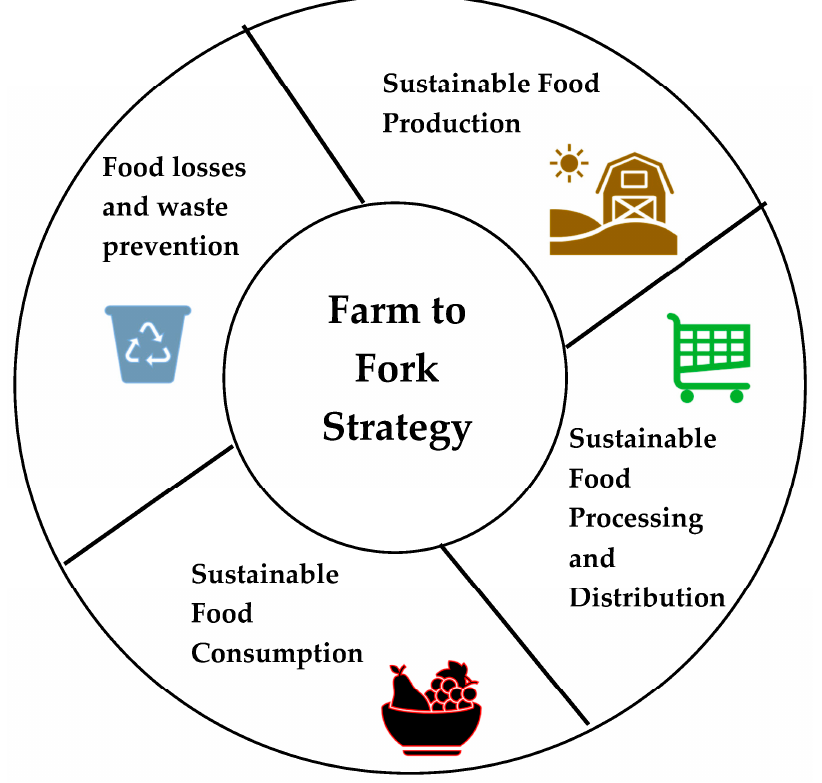
Figure 1. Farm to fork strategy (main goals/areas of intervention). Own elaboration from: “Farm to fork strategy” of the European Union [15].